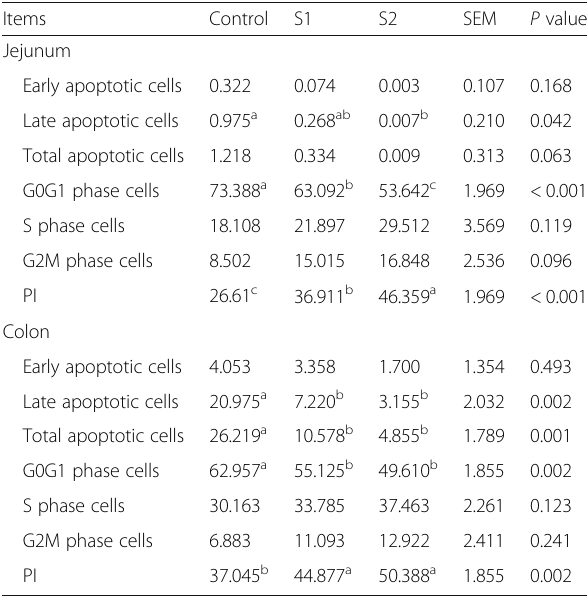
Table 4 Effect of gastric infusion of SCFA on apoptosis and cell cycle in jejunum and colon of weaned piglets (%)